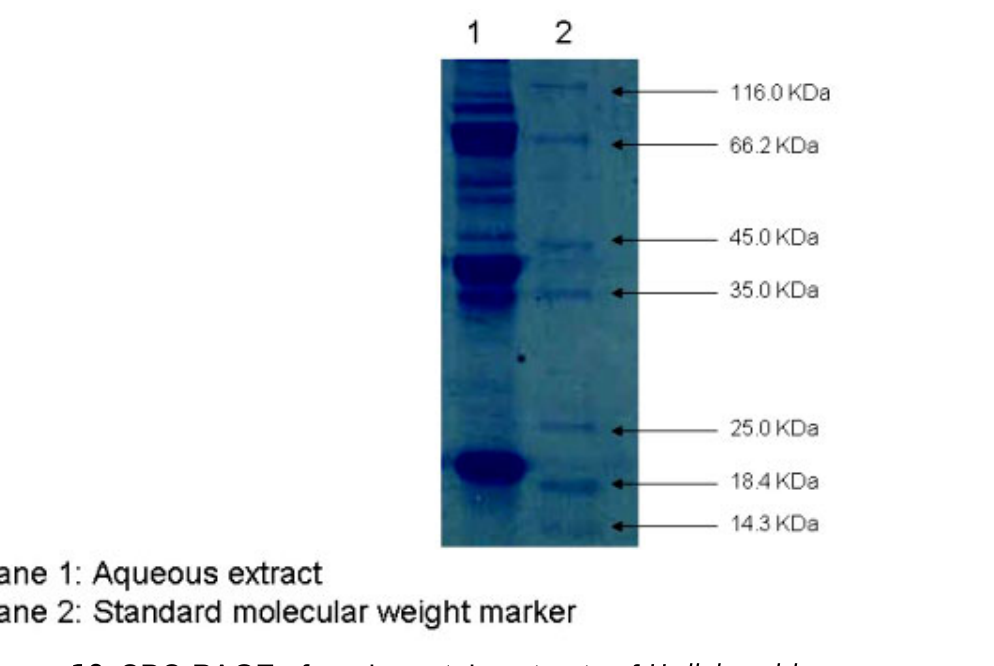
Figure 10. SDS-PAGE of crude protein extracts of Halichondria panacea